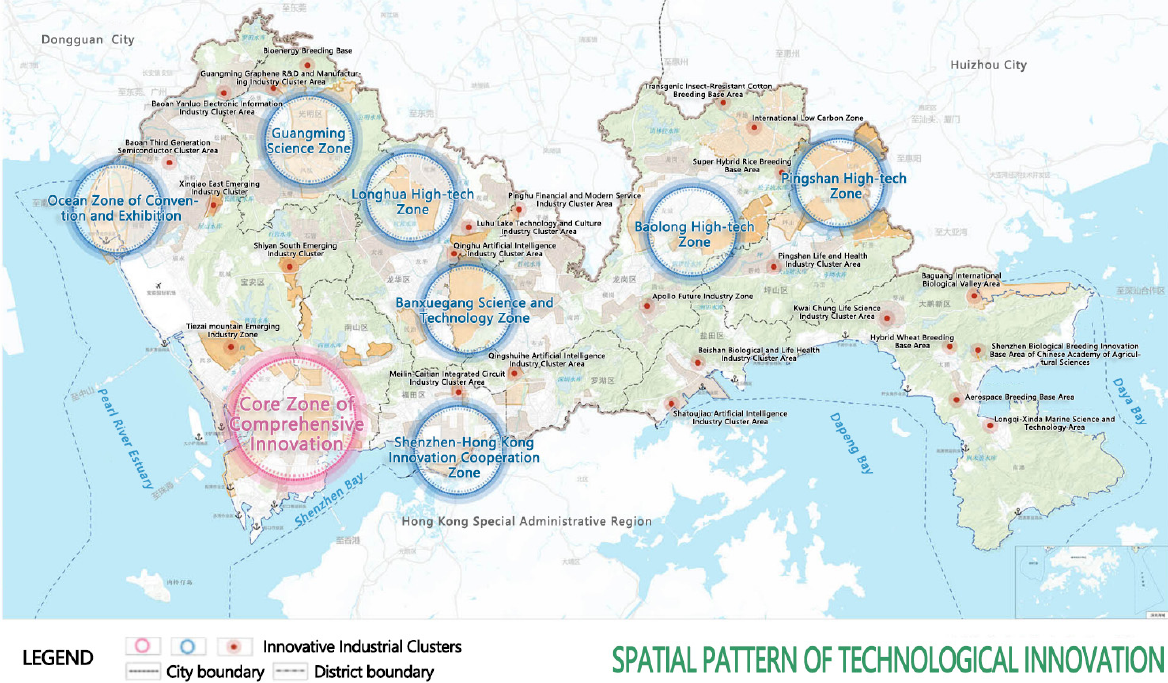
Figure A6. Shenzhen Innovation Industry Cluster.